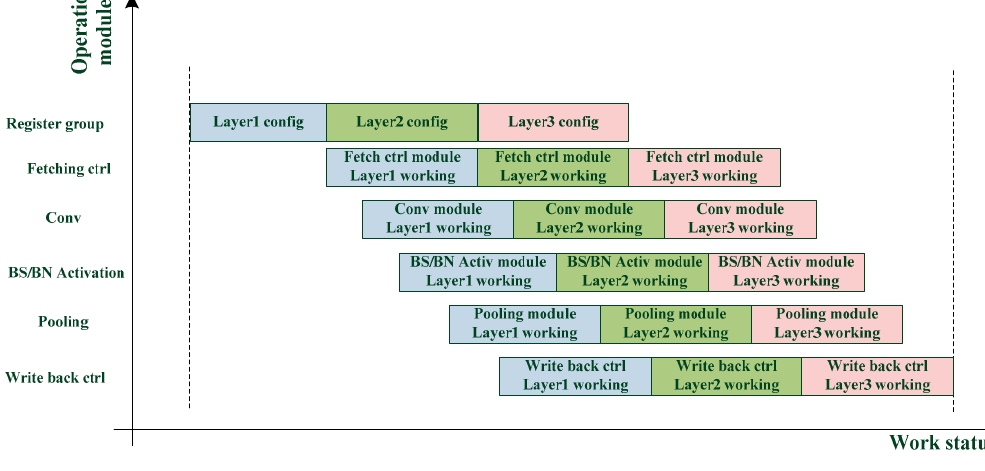
Figure 5. Processing of dual configuration register group structure.